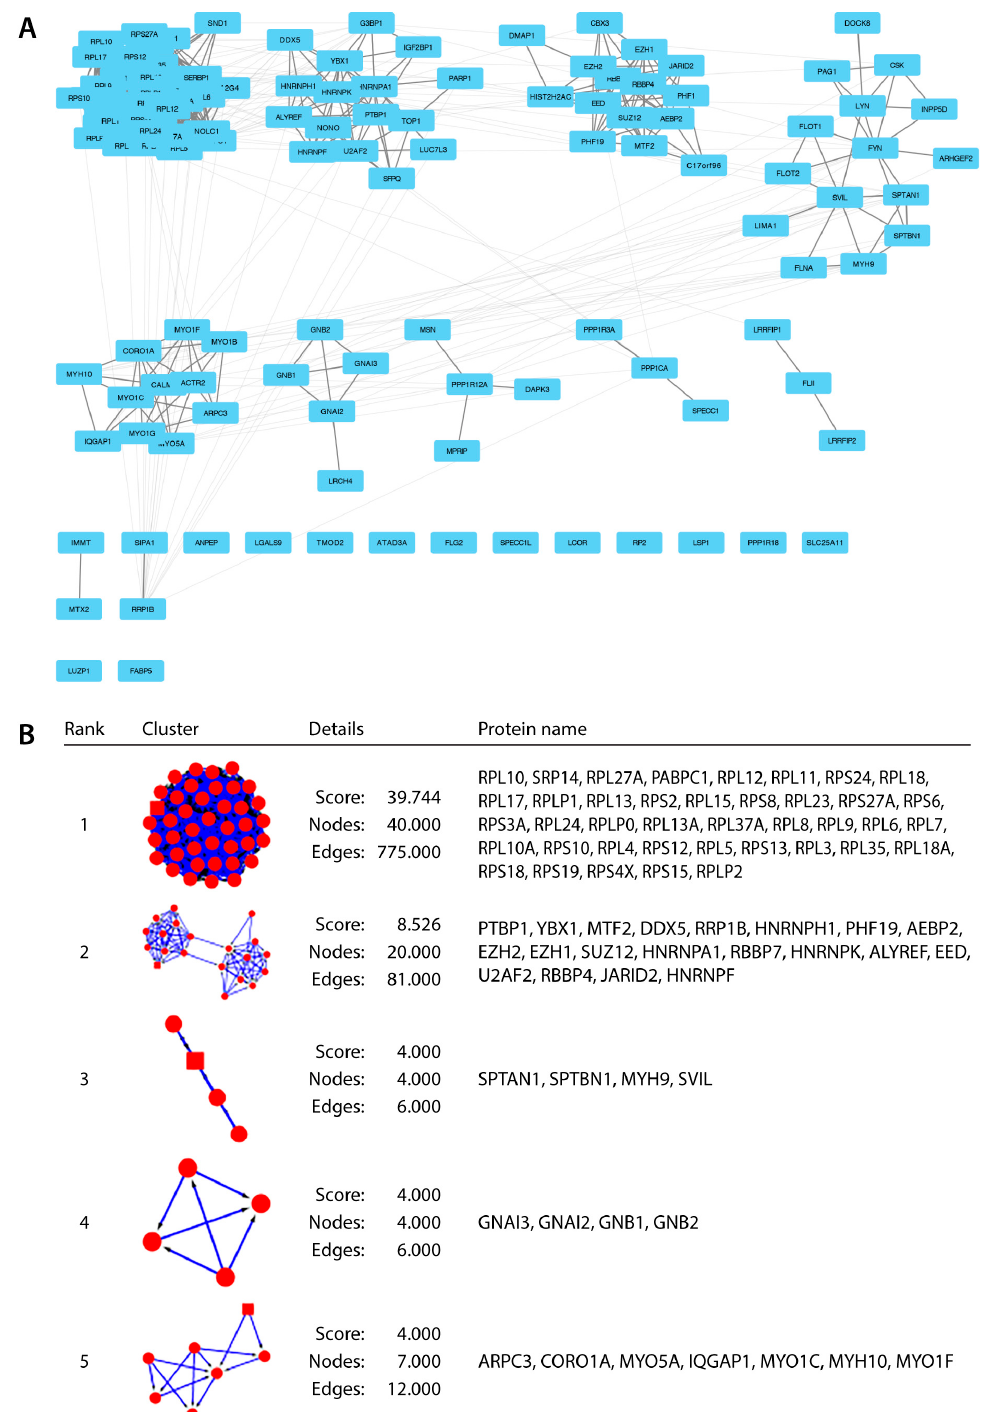
Figure 2. The EZH2 interactome in HL-60 acute myeloid leukaemia (AML) cells. ( A ) Network analysis of EZH2 interactome (2-fold change over IgG and 0.8 SAINTexpress score) showing related groups of proteins as clustered by Cytoscape (Makarov Clustering Algorithm in clusterMaker). Groups of PRC2 interacting proteins (third node from the left), as well as for RNA binding proteins involved in translation and splicing (first and second nodes on the top) can be distinguished; ( B ) MCODE clusters with protein symbols in each node confirming strong enrichment for RNA binding proteins (cluster 1) and known PRC2 associated members (cluster 2).